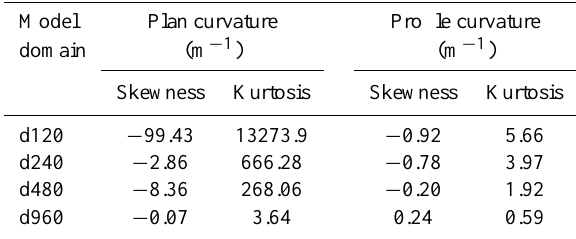
Table 2. Heterogeneity analysis of topography at different grid res-